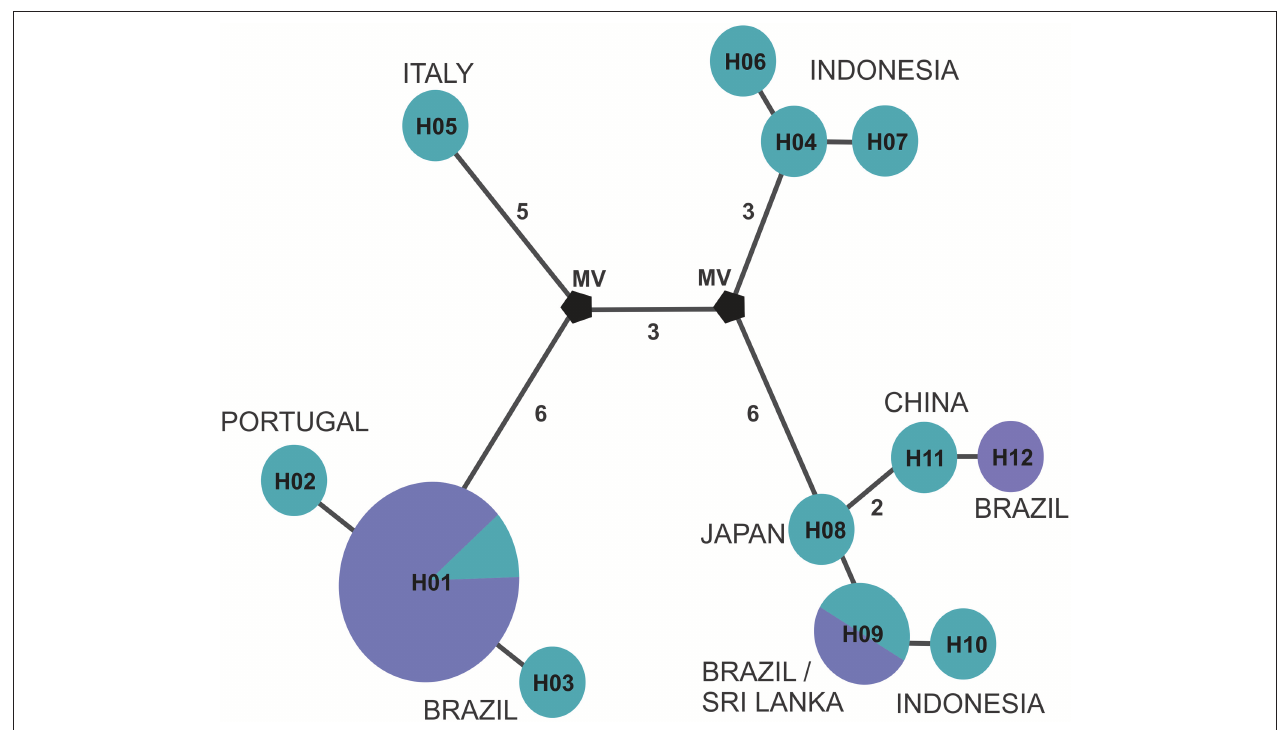
FIGURE 5 | MJ analysis of Sus scrofa carried out with variable sites. Values next to branches indicate the number of mutations between two haplotypes. Branches without values, showed only one mutation. Purple circles or slices, represents samples purchased in this work. Green circles or slices, represents GB sequences. Haplotypes are described in Table 3